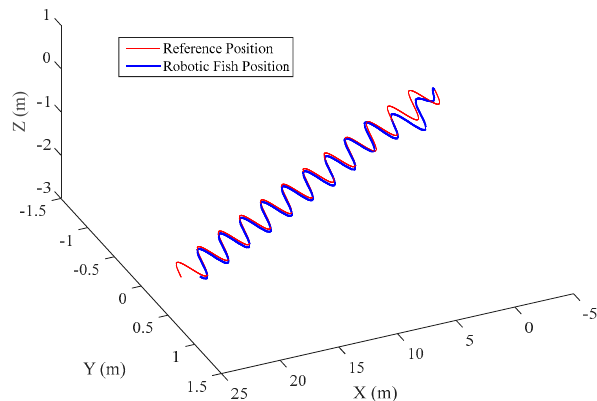
Figure 19. 3D P 1 tracking control performance.